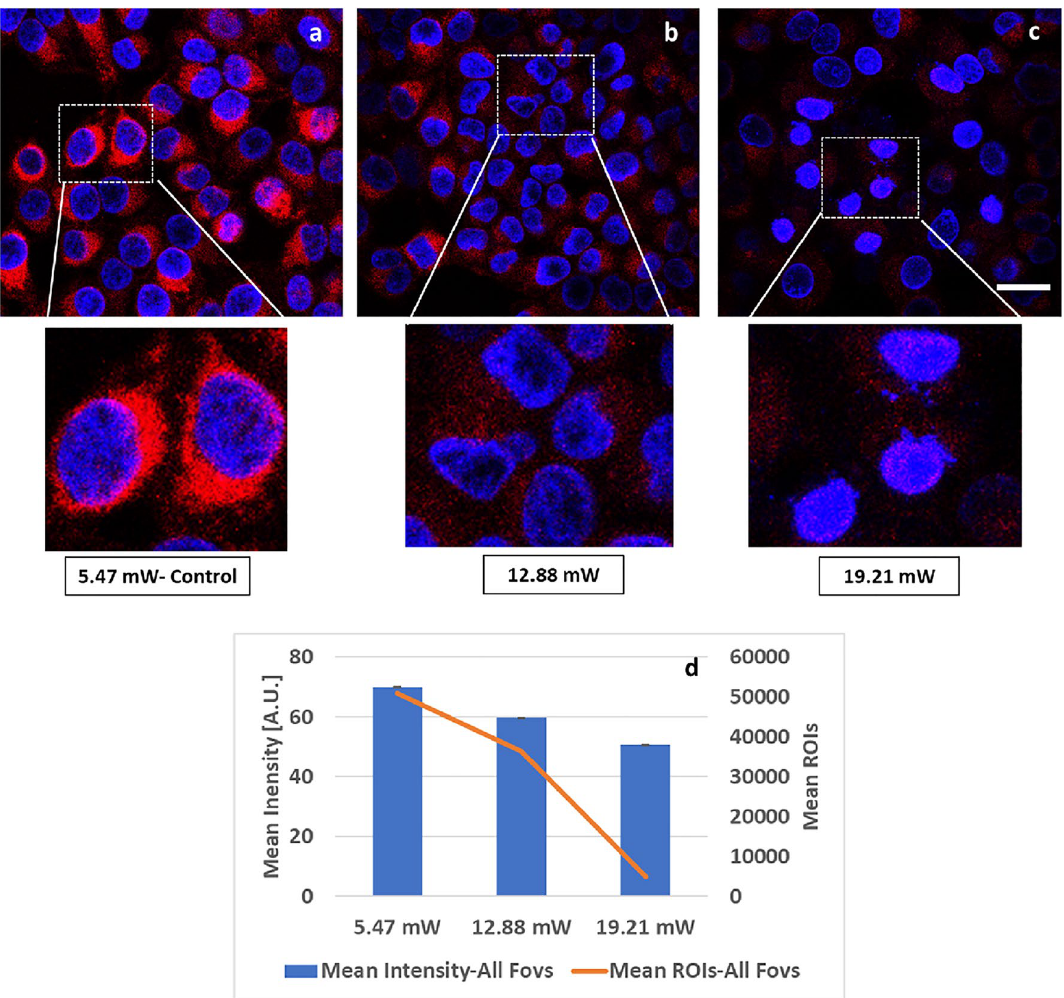
Figure 5. Mitochondrial fragmentation at increasing 2p-laser power in HeLa Cells. Representative confocal images of MitoTracker Red FM signals, imaged under identical conditions by confocal 594 nm excitation at 2.8% (Em-600–701 nm, PMT 850v) after FLIM acquisition at 740 nm. ( a ) Viable mitochondria after 5.47 mW–Control FLIM acquisition. ( b , c) After higher FLIM laser power at 12.88 mW & 19.21 mW, increased mitochondrial fragmentation and loss in MitoTracker Red signal occurs. Hoechst nuclear stain. ( d ) Mean intensity (± SEM) bar plots and mean ROI counts (2 × 2 pixel, orange line) from 4 FOVs show a decrease in MitoTracker Red mean gray-level intensity (8-bit depth) from 69.86 to 59.71 (14.52% decrease) to 50.74 (27.36% decrease); and mean ROI counts (orange line) from 50,923.25 to 36,500 (28.32% decrease) to 4,971.66 (90.23% decrease) in ROI counts after FLIM with 5.47 mW-Control, 12.88 mW and 19.21 mW respectively, demonstrating drop in signal with higher laser average power. Single factor Anova analysis for mean